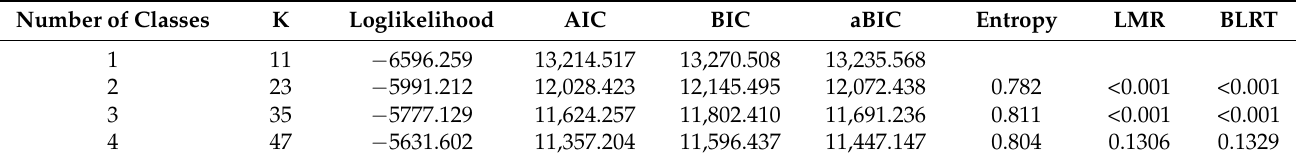
Table 2. Fit statistics for latent class